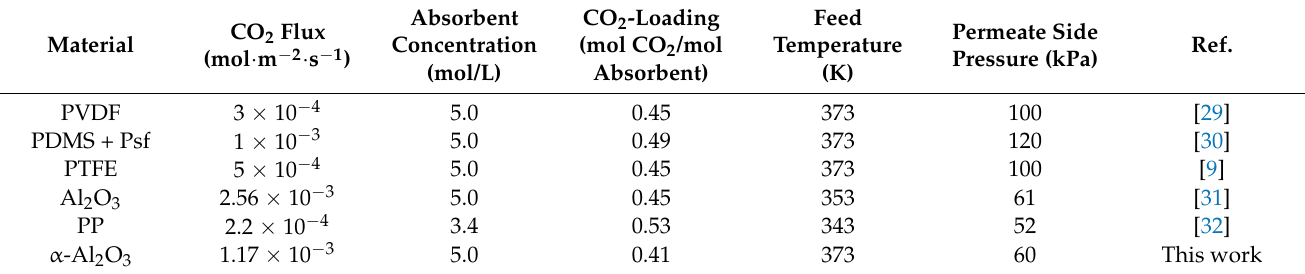
Table 2. Performance of several kinds of membranes for CO 2 desorption from MEA solution.